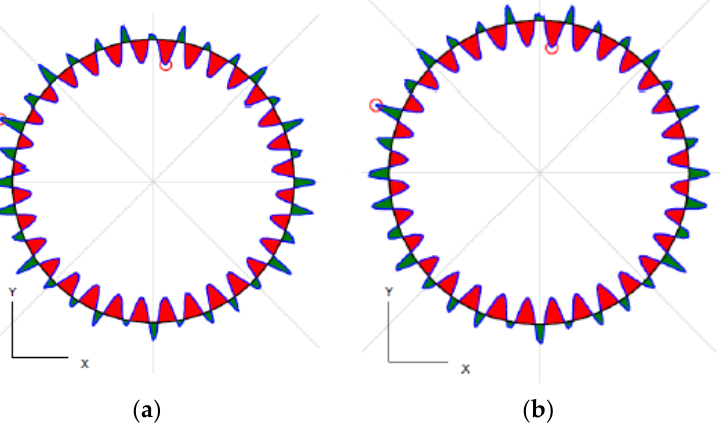
Figure 13. Roundness deviations ( a ) constant step over – pocket auto border strategies; ( b ) spiral strategy. The roundness values for the single measured circular paths are shown in Table